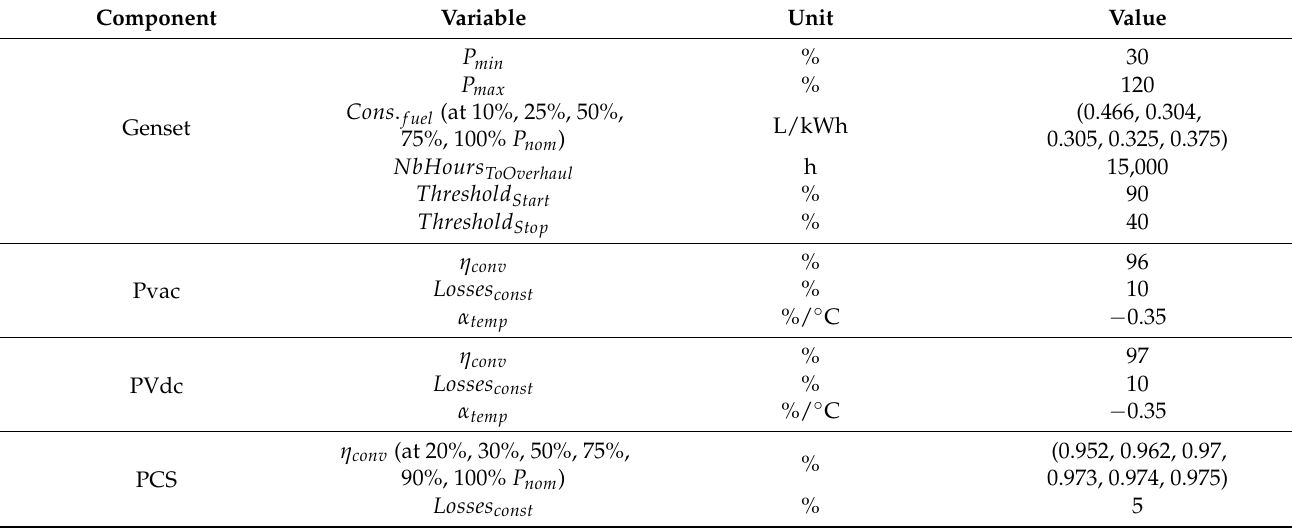
Table A1. Technical parameters of the optimization